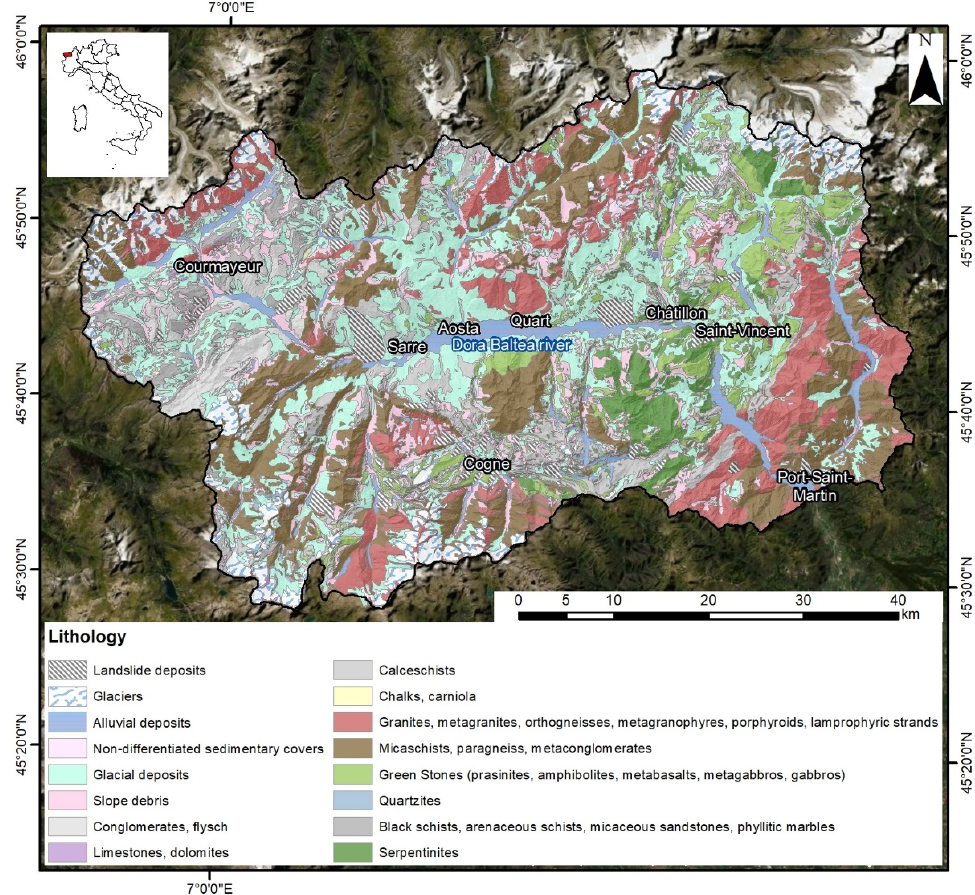
Figure 1. Litho-technical map of the Valle d’Aosta Region, Italy, distributed by regional authorities.